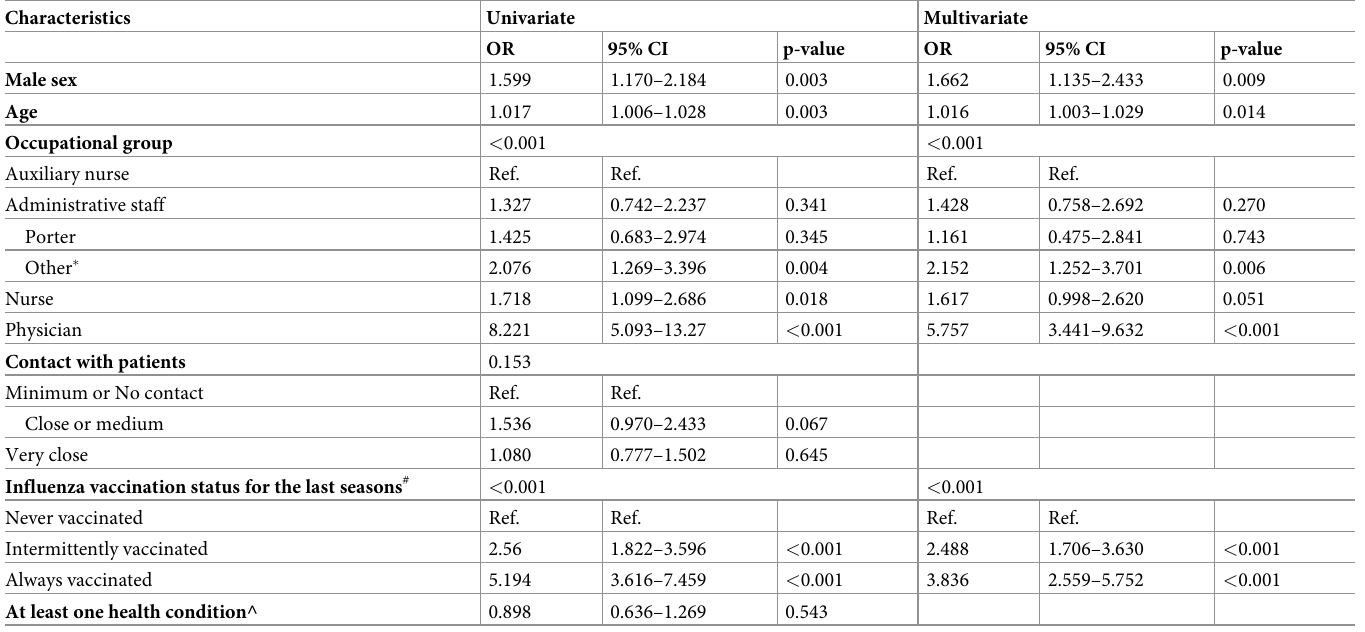
Table 3. Univariate and multivariate logistic regression of factors associated with the intention to receive COVID-19 vaccination as soon as